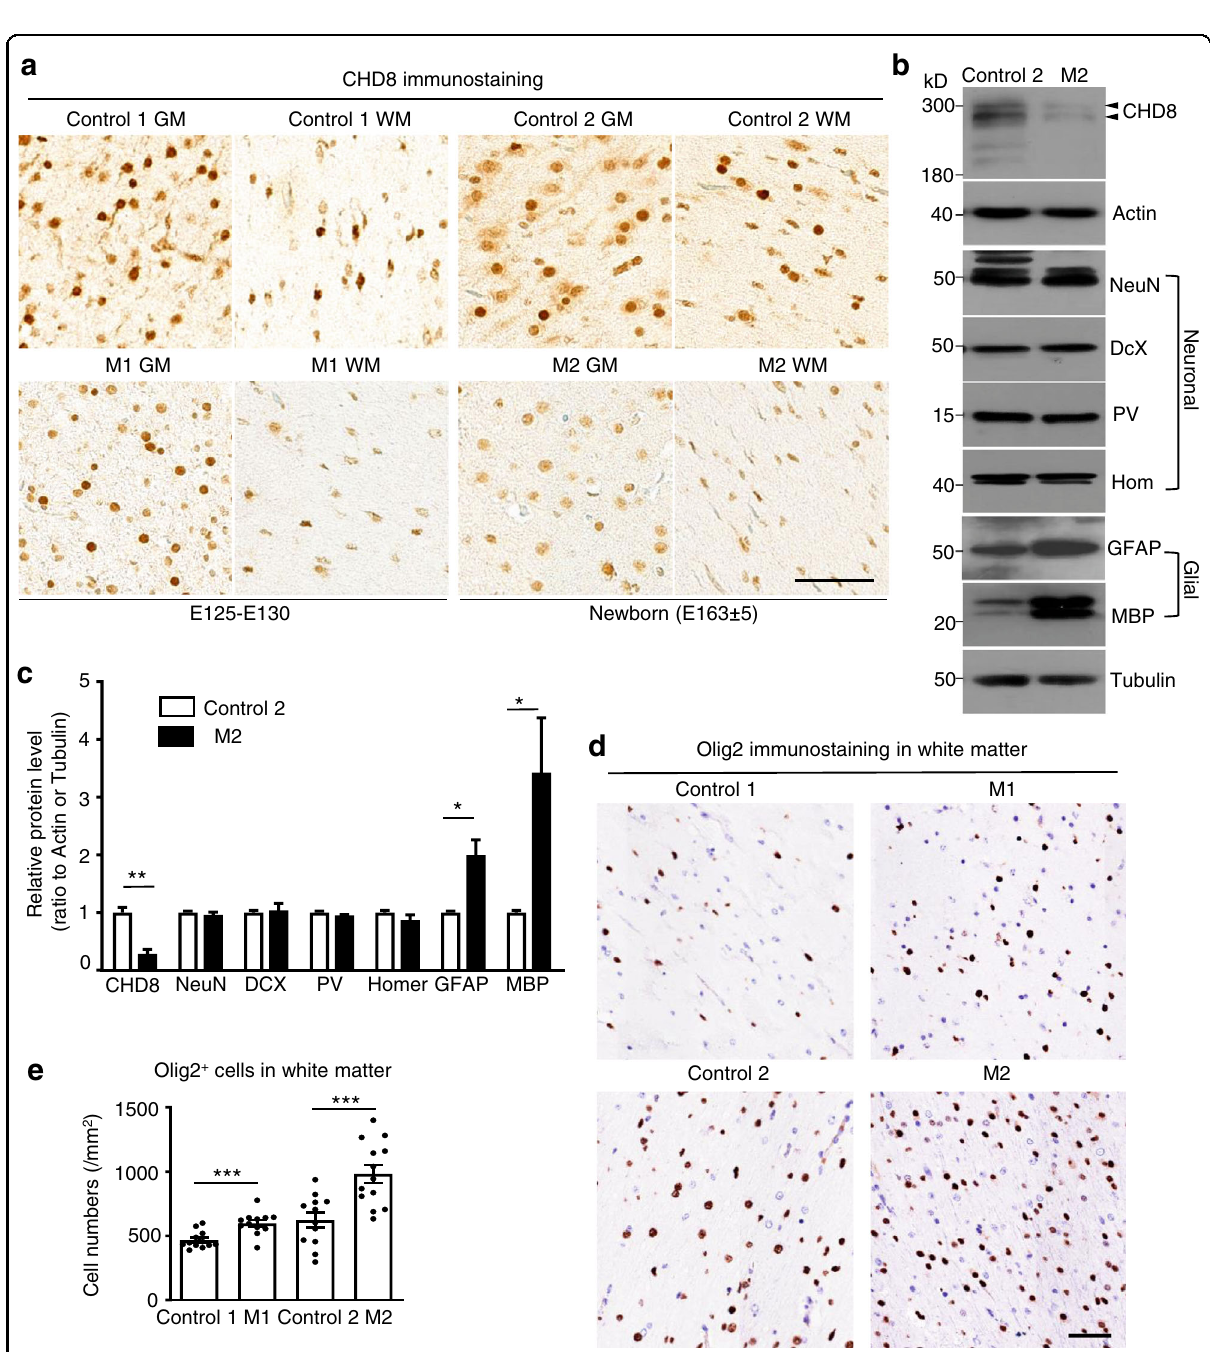
Fig. 2 CHD8 mutant monkeys have decreased CHD8 expression, increased glial marker levels and normal neuronal marker levels. a Immunostaining of the prefrontal cortex gray matter (GM) and white matter (WM) of control and CHD8 mutant monkeys (M1, M2) with anti-CHD8 antibody. CHD8 shows a higher expression in E125 – E130 than newborn (E163 ± 5). Scale bar: 50 μ m. b Western blotting of the prefrontal cortex of the newborn monkeys (control-2 and M2). The blots were probed with antibodies to neuronal proteins (NeuN, DcX, PV, and Hom) and glial proteins (GFAP, MBP). Tubulin served as a loading control. c Quanti fi cation of the ratios of neuronal and glial proteins to the loading control on western blots. The data were obtained from four western blotting experiments and are presented as means ± SEM. * P < 0.05; ** P < 0.01. d Immunostaining of the white matter of control and CHD8 mutant monkeys with an antibody to olig2, a marker protein for oligodendrocytes. The nucleus was stained with hematoxylin. Scale bar: 50 μ m. e Density of oligodendrocytes in the white matter of control and CHD8 mutant monkeys. The data were obtained by counting 12 images and presented as means ± SEM per mm 2 . *** P <